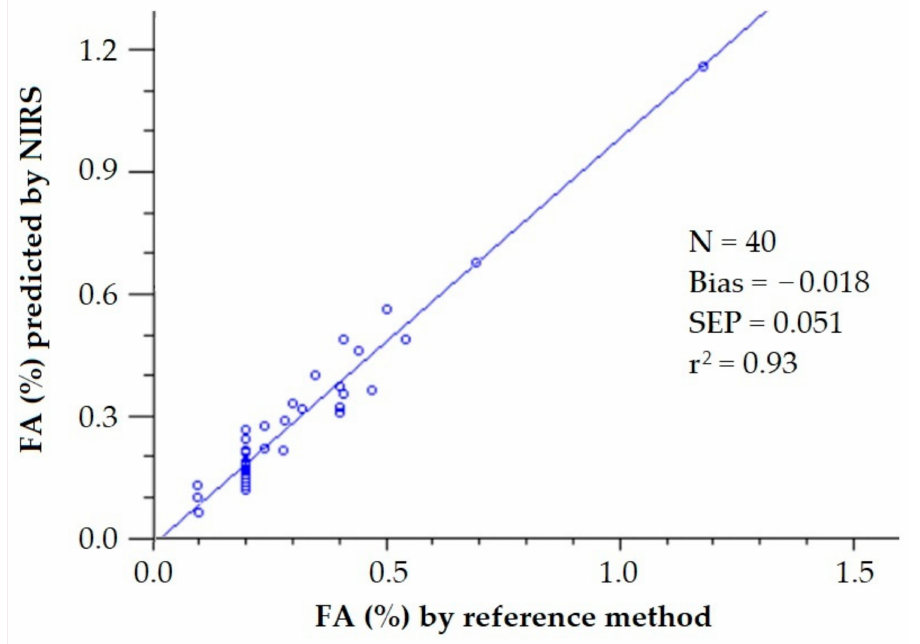
Figure 9. Validation exercise for the determination of the free acidity of olive oil by PLS-NIRS using 85 wavelengths from the NIR spectrum (FA values retrieved from [22]). Table 3. Spectral bands’ tentative assignments correlated to FA of olive oil obtained by the Monte Carlo uninformative variable elimination (MCUVE) method and the successive projections algorithm